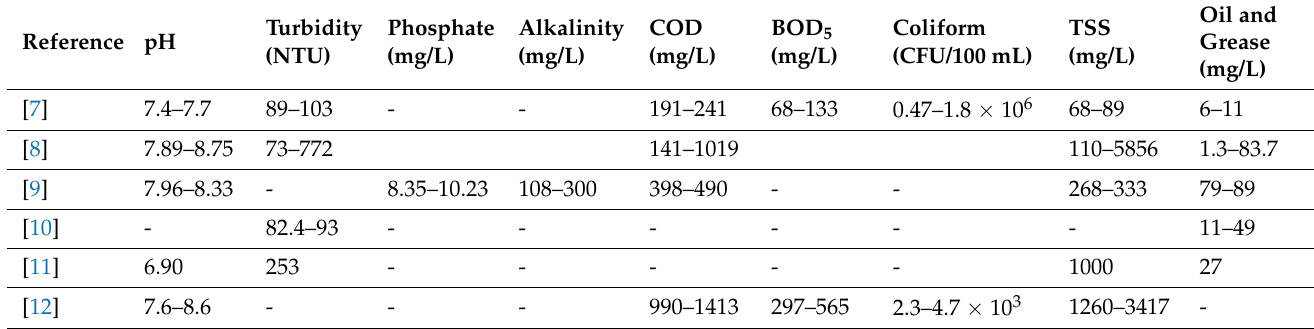
Table 1. Pollutants characteristics in car wash station